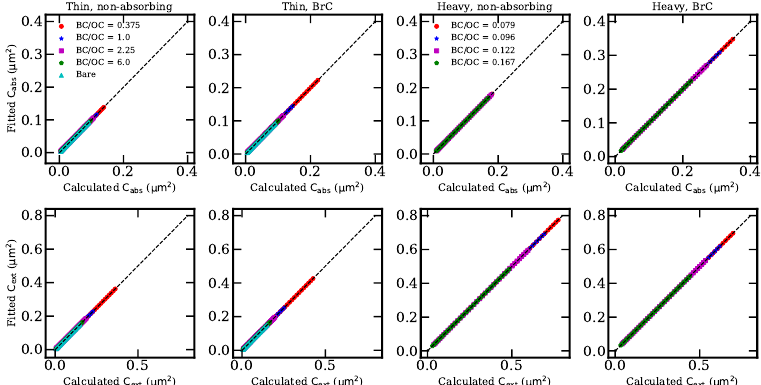
Figure 7. Similar to Figure 6, but for absorption and extinction cross-sections (350 nm), where the correlation coefficients ( R 2 ) > 0.999 and the normalized mean absolute errors (NMAE) < 10 − 10